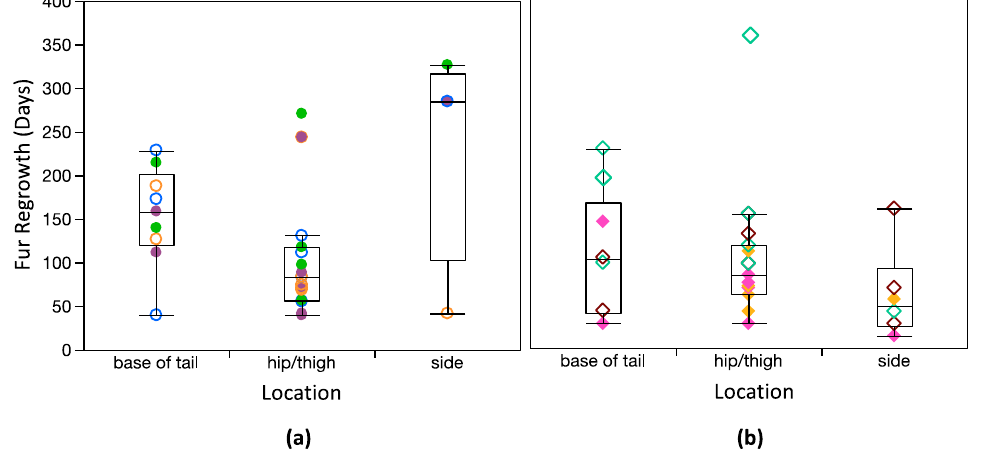
Figure 5. Box plots comparing regrowth among simplified shave locations for: ( a ) dwarf lemurs and ( b ) mouse lemurs. Boxes represent 25 and 75% quartiles, and whiskers contain 1.5 times the interquartile range. Measurements for Poblano’s RS3 (hip / thigh) and LS4 (base of tail) are shown but excluded from box plots and statistical comparisons. Symbology corresponds with Figures 1 and 2. Males are open symbols; females are closed symbols.